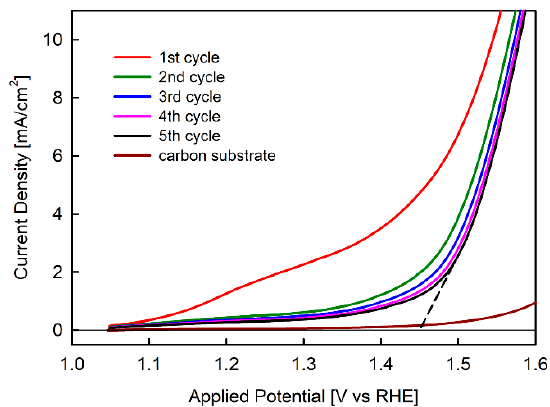
Figure 1. Linear sweep voltammetry (LSV) for the plasma-deposited Ru-based film. Current density as a function of applied potential (V vs reversible hydrogen electrode (RHE)) for five successive measurement cycles. The LSV for the carbon substrate is also shown.